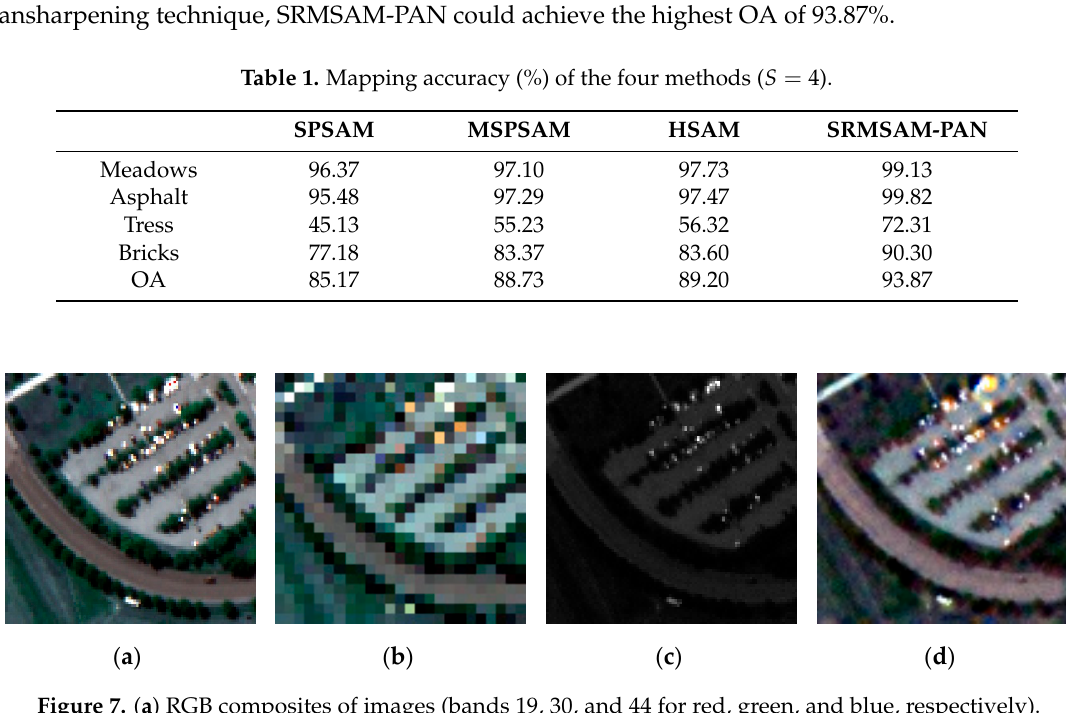
Figure 7. ( a ) RGB composites of images (bands 19, 30, and 44 for red, green, and blue, respectively). ( b ) Coarse image ( 4 S = ). ( c ) Panchromatic image. ( d ) Pansharpening result.